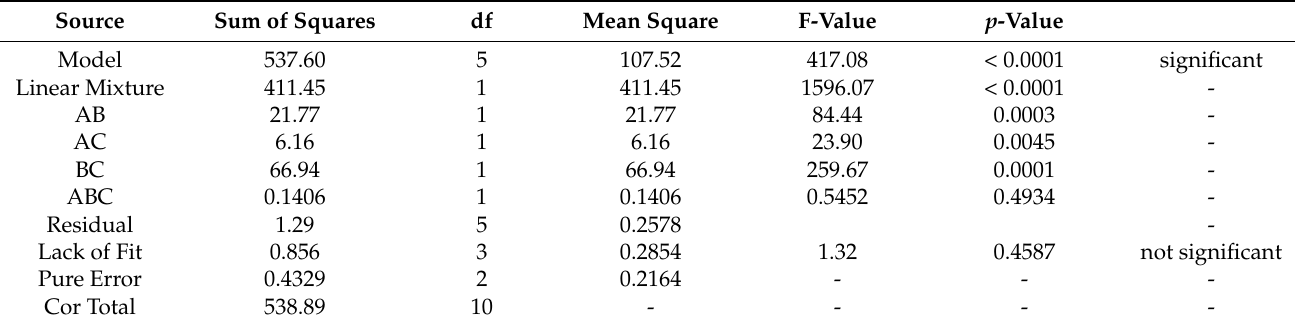
Table 8. ANOVA table of crystallinity for quadratic and linear